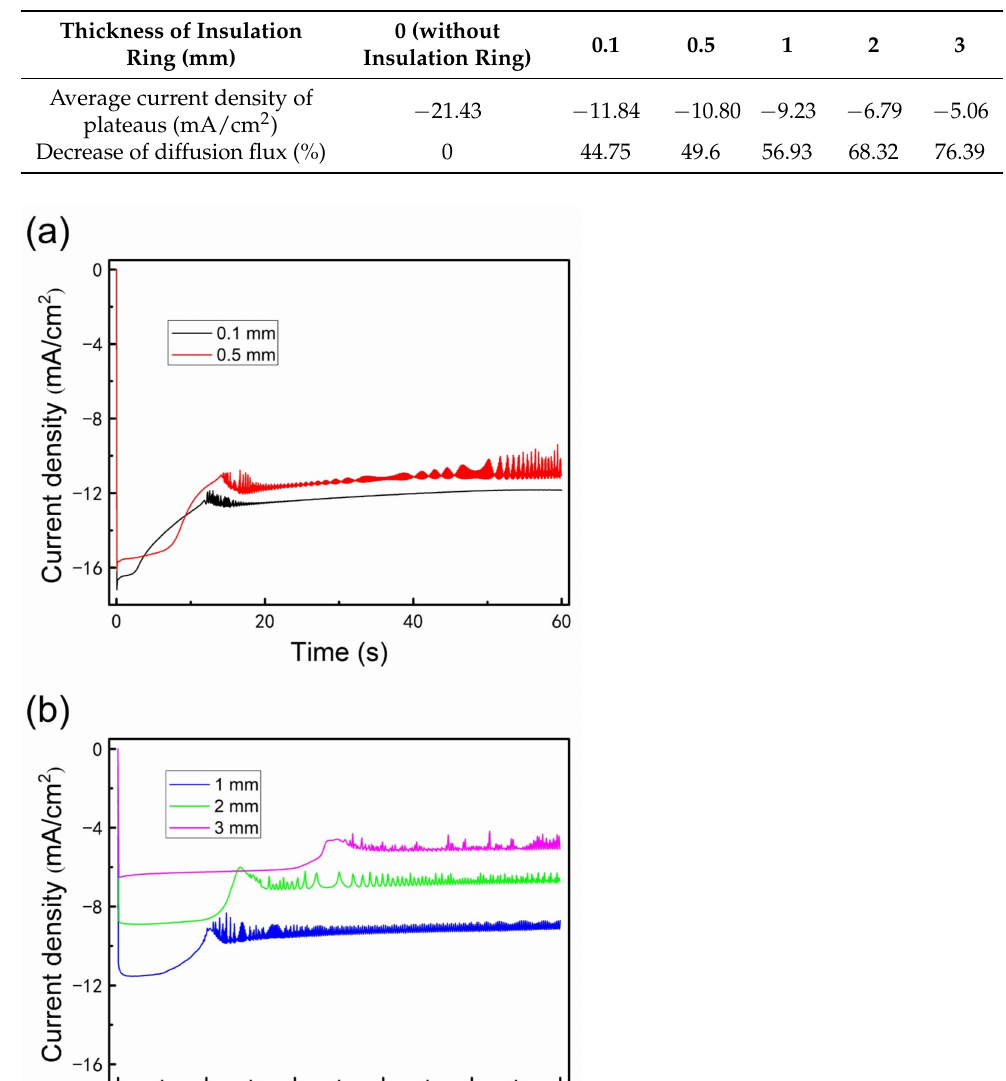
Table 1. Average current densities of plateaus and the decrease of diffusion flux, using different thicknesses of insulation ring (inner diameter was 6 mm) according to Figures 2a and 4.